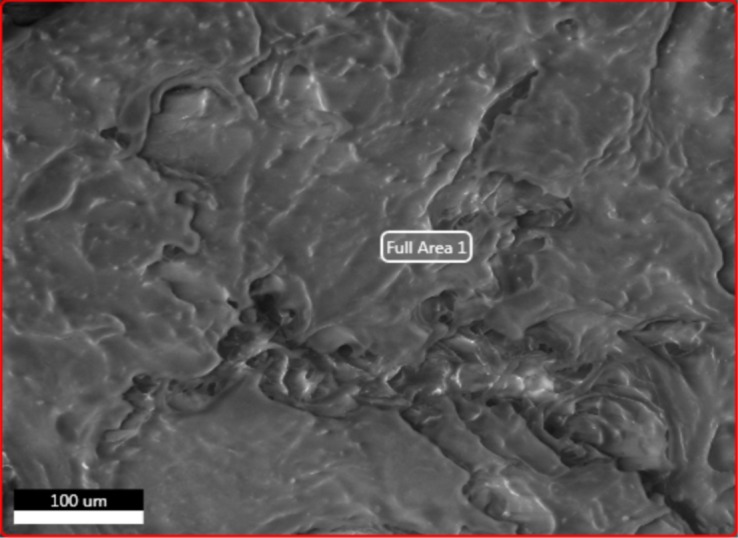
Electron image of modern demineralised chicken bone full area 1 EDS analysis.